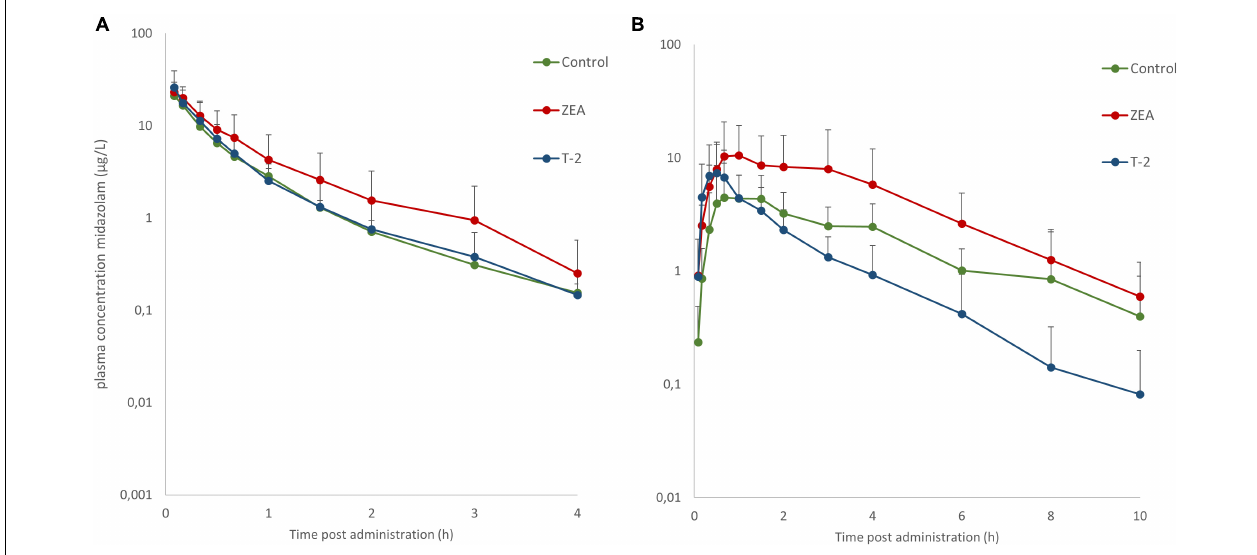
FIGURE 1 | Mean (+SD) plasma concentration-time profiles for midazolam (MDZ) after administration of a single intravenous dose of 0.036 mg/kg BW (A) and oral dose of 0.15 mg/kg BW (B) . Control and T-2 group: n = 8, 4 boars and 4 sows, 9 weeks of age; ZEA group: n = 7, 4 boars and 3 sows, 9 weeks of age.